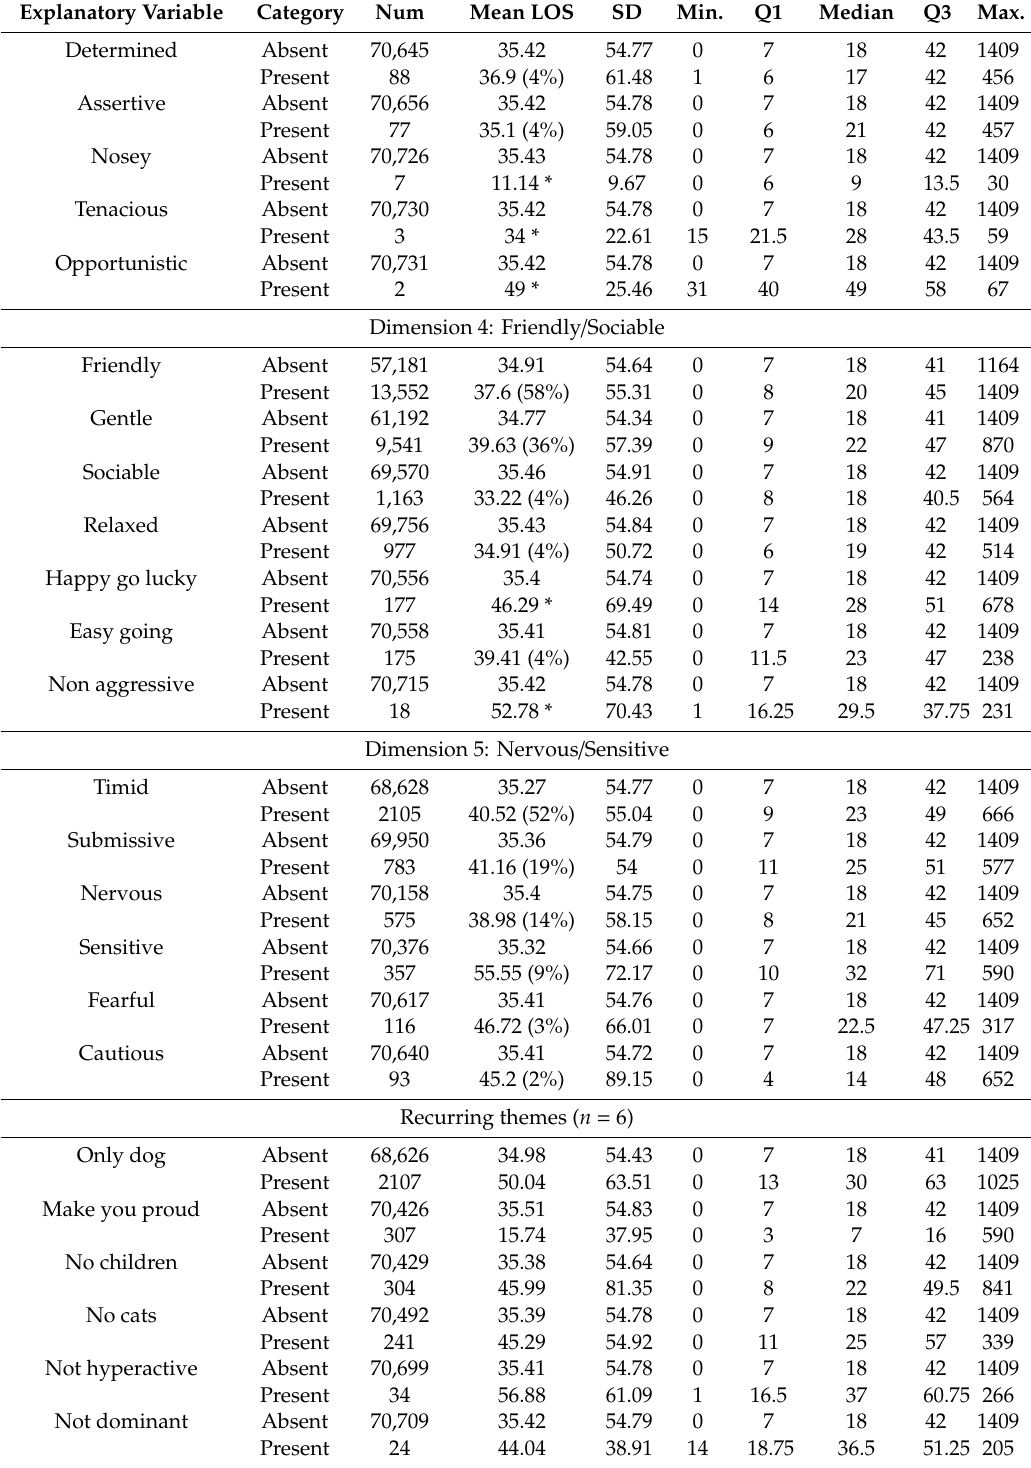
self-assured / motivated (seven adjectives), responsiveness to training (10 adjectives), friendly /